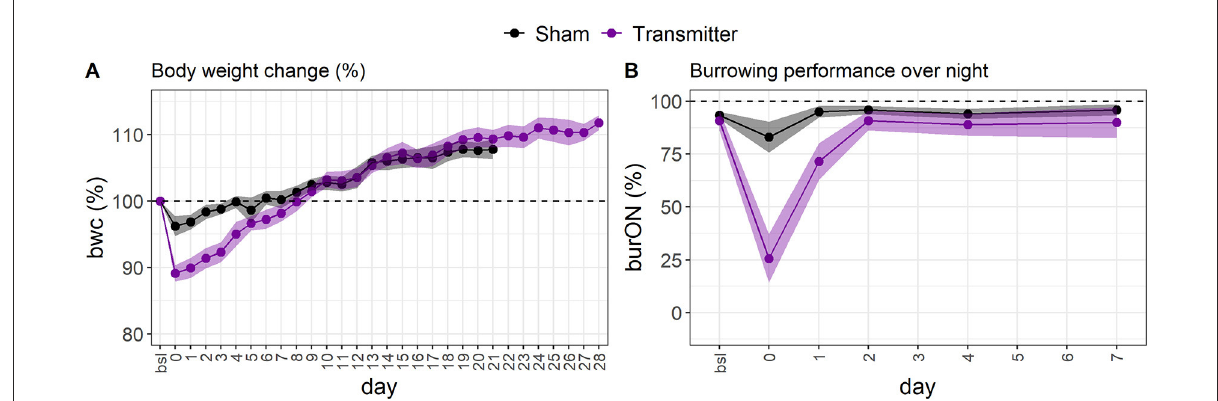
FIGURE2 (A) The standardized, average body weight change indicates impairments to animal welfare in female C57BL6/J mice. The loss in bwc is most extensive after surgery (day 0) in the TM-implanted group (mauve, n = 13). The loss in body weight is less severe in the Sham group (black dots, n = 15). On average, the animals recovered back to baseline levels at around day eight. After day eight, the animals gained weight. The errors are depicted as 95% confidence bands. (B) The standardized, average overnight burrowing performance (burON) in female C57BL6/J mice also showed a sharp drop after surgery (day 0). However, the performance loss is higher in the TM group ( n = 13) than in the Sham group ( n = 15). The burrowing behavior returns faster back to baseline levels than the bwc variable. The animals regained normal burrowing behavior on day